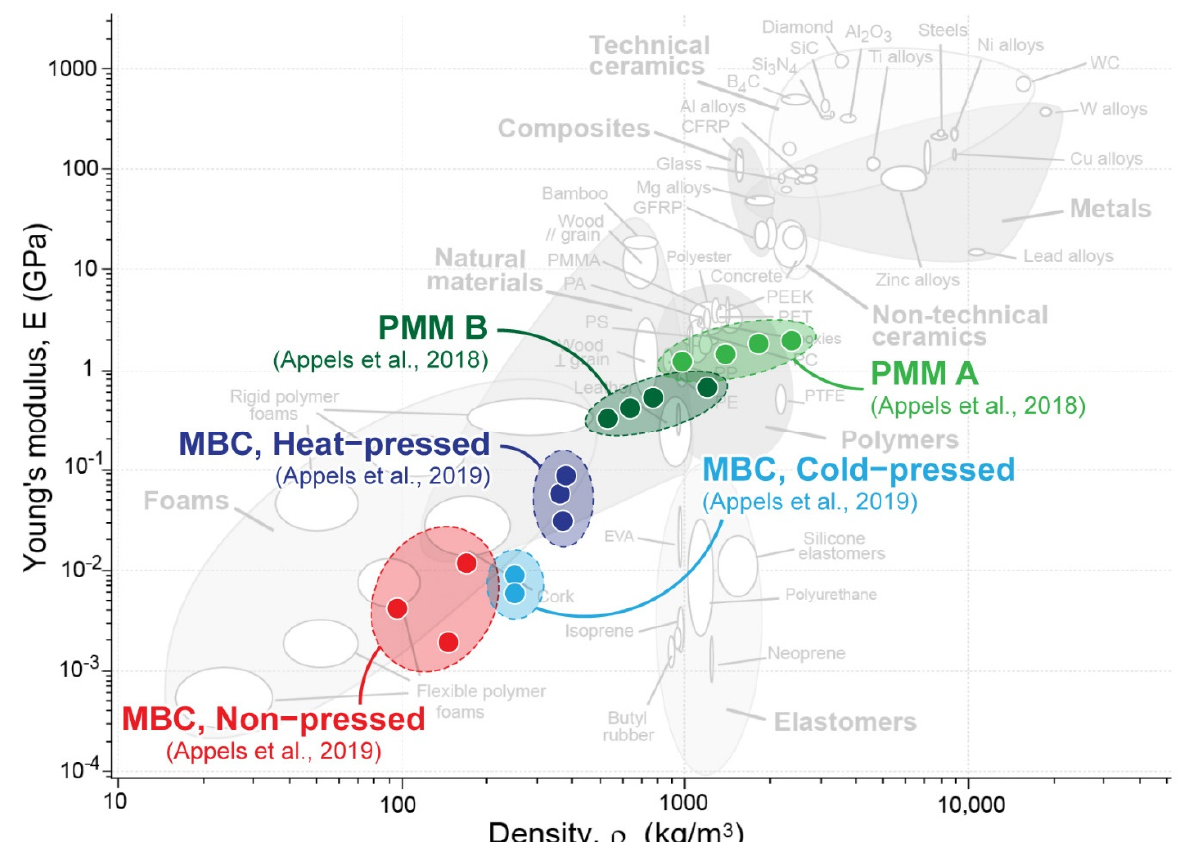
Figure 2. A comparison of mycelium-based materials to standard materials, with data adapted from [30,31]. Underlying Ashby plot created using CES EduPack 2019, ANSYS Granta © 2020 Granta Design.